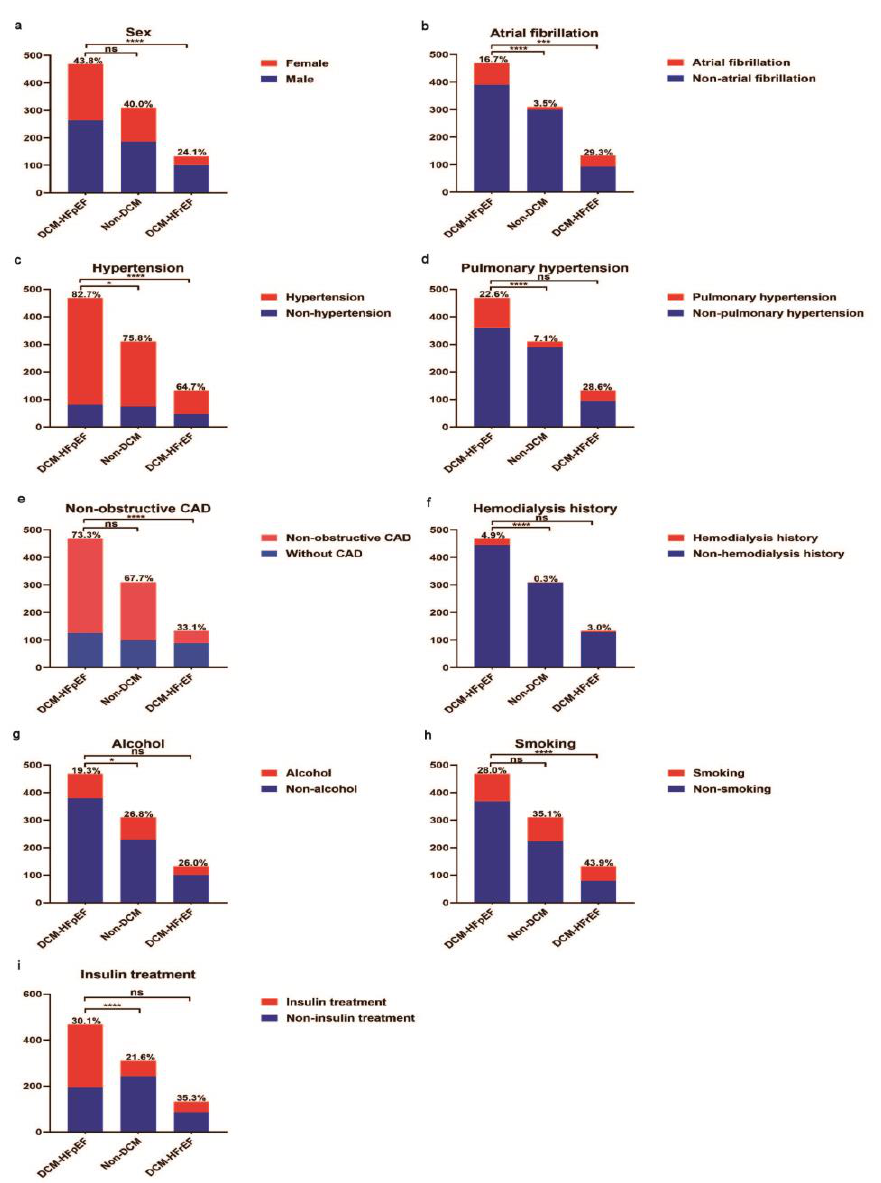
Figure 2. Comparison of demographic information during hospitalization of DCM-HFpEF vs. non-DCM and DCM-HFrEF vs. DCM-HFpEF patients. (a) Gender differences between DCM-HFpEF and non-DCM patients were not obvious. Compared with DCM-HFrEF patients, DCM-HFpEF patients were more likely to be female. (b) DCM-HFpEF patients had a higher proportion of atrial fibrillation vs. non-DCM and a lower proportion of atrial fibrillation vs. DCM-HFrEF. (c) Patients had a higher proportion of hypertension in DCM-HFpEF vs. non-DCM and DCM-HFrEF. (d) Patients had a higher proportion of pulmonary hypertension in DCM-HFpEF vs. non-DCM, but differences between DCM-HFpEF and DCM-HFrEF were not obvious. (e) Patients had a higher proportion of non-obstructive CAD in DCM-HFpEF vs. DCM-HFrEF. (f) Patients had a higher proportion of hemodialysis history in DCM-HFpEF vs. non-DCM. (g) DCM-HFpEF patients had a lower proportion of alcohol assumption vs. non-DCM. (h) DCM-HFrEF patients had a higher proportion of smoking assumption vs. DCM-HFpEF. (i) DCM-HFpEF patients had a higher proportion of insulin treatment vs. non-DCM. CAD: coronary artery disease; DCM: diabetic cardiomyopathy; HFrEF: heart failure with reduced ejection fraction; HFpEF: heart failure with preserved ejection fraction. * p < 0.05. ** p < 0.01. *** p < 0.005. **** p < 0.001.